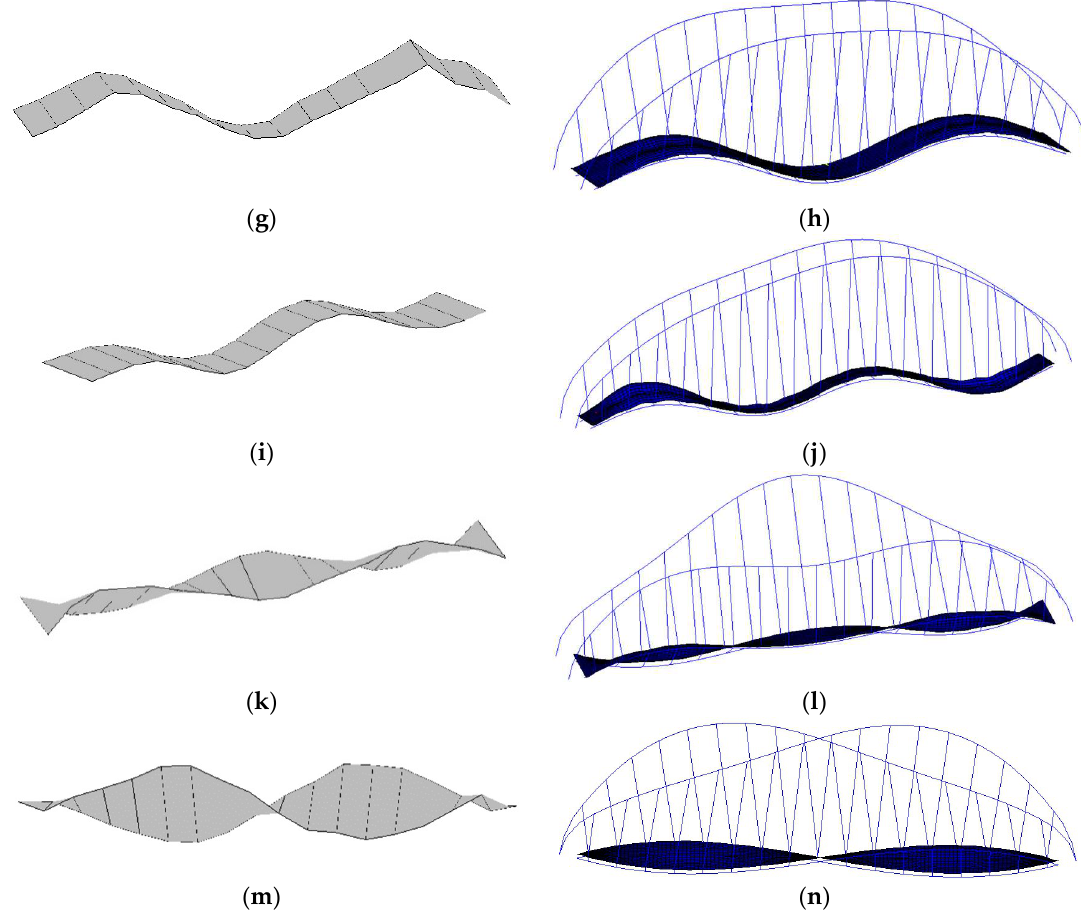
Figure 10. Mode coupled by the deck and arch: ( a ) the 3rd mode identified by SSI-COV (1.99 Hz); ( b ) the 3rd mode calculated by ANSYS (2.00 Hz); ( c ) the 4th mode identified by SSI-COV (2.34 Hz); ( d ) the 4th mode calculated by ANSYS (2.56 Hz); ( e ) the 6th mode identified by SSI-COV (3.94 Hz); ( f ) the 6th mode calculated by ANSYS (3.81 Hz); ( g ) the 7th mode identified by SSI-COV (4.39 Hz); ( h ) the 7th mode calculated by ANSYS (4.34 Hz);( i ) the 9th mode identified by SSI-COV (6.48 Hz); ( j ) the 9th mode calculated by ANSYS (6.54 Hz); ( k ) the 10th mode identified by SSI-COV (7.03 Hz)); ( l ) the 10th mode calculated by ANSYS (7.32 Hz); ( m ) the 11th mode identified by SSI-COV (8.32 Hz); ( n ) the 11th mode calculated by ANSYS (8.64 Hz).